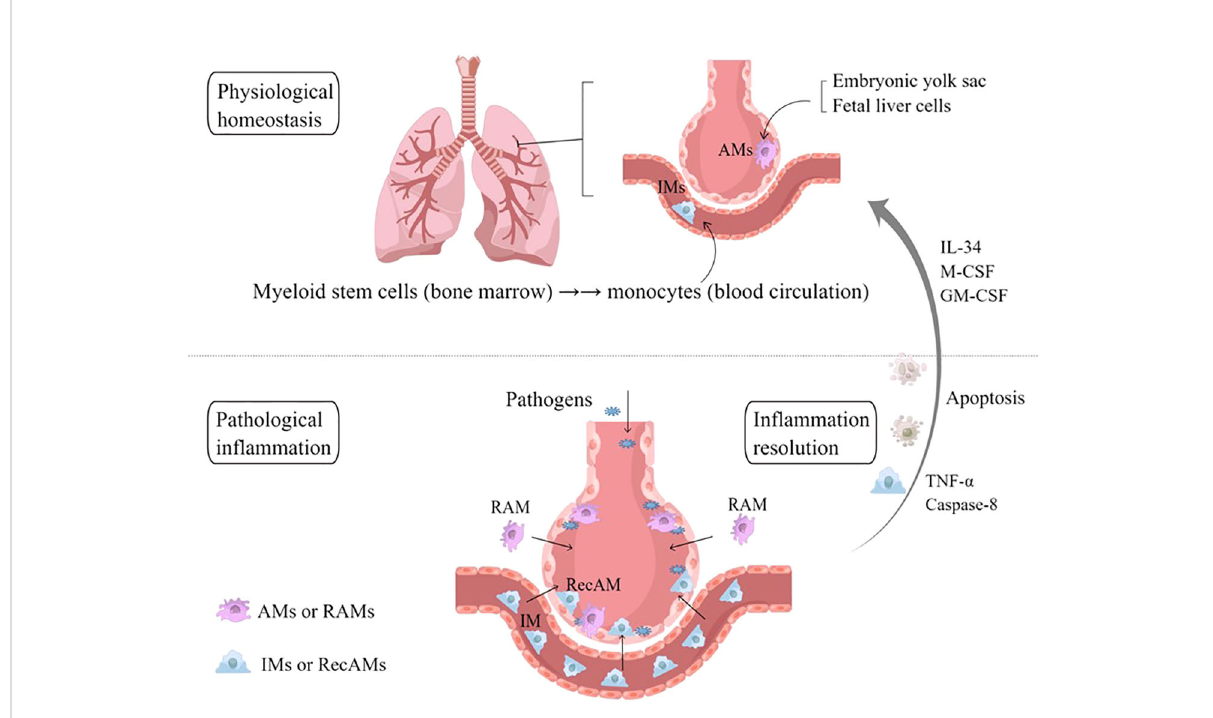
FIGURE 2 Sources and classi fi cation of AMs. In physiological homeostasis, AMs are equivalent to RAMs, which originate from embryonic yolk sacs and fetal liver cells. In the event of a large number of microbial invasion or inhalation of allergens, IMs are recruited into the alveoli, known as RecAMs. After the in fl ammation subsides, RecAMs coming from IMs will undergo programmed apoptosis, while RAMs maintain their original distribution characteristics under the action of IL-34, M-CSF, and GM-CSF. AMs, alveolar macrophages; IMs, interstitial macrophages; RAMs, resident airspace macrophages; RecAMs, recruited airspace macrophages; IL, interleukin; GM-CSF, granulocyte – macrophage colony-stimulating factor; M-CSF, macrophage colony-stimulating factor; TNF- a , tumor necrosis factor- a